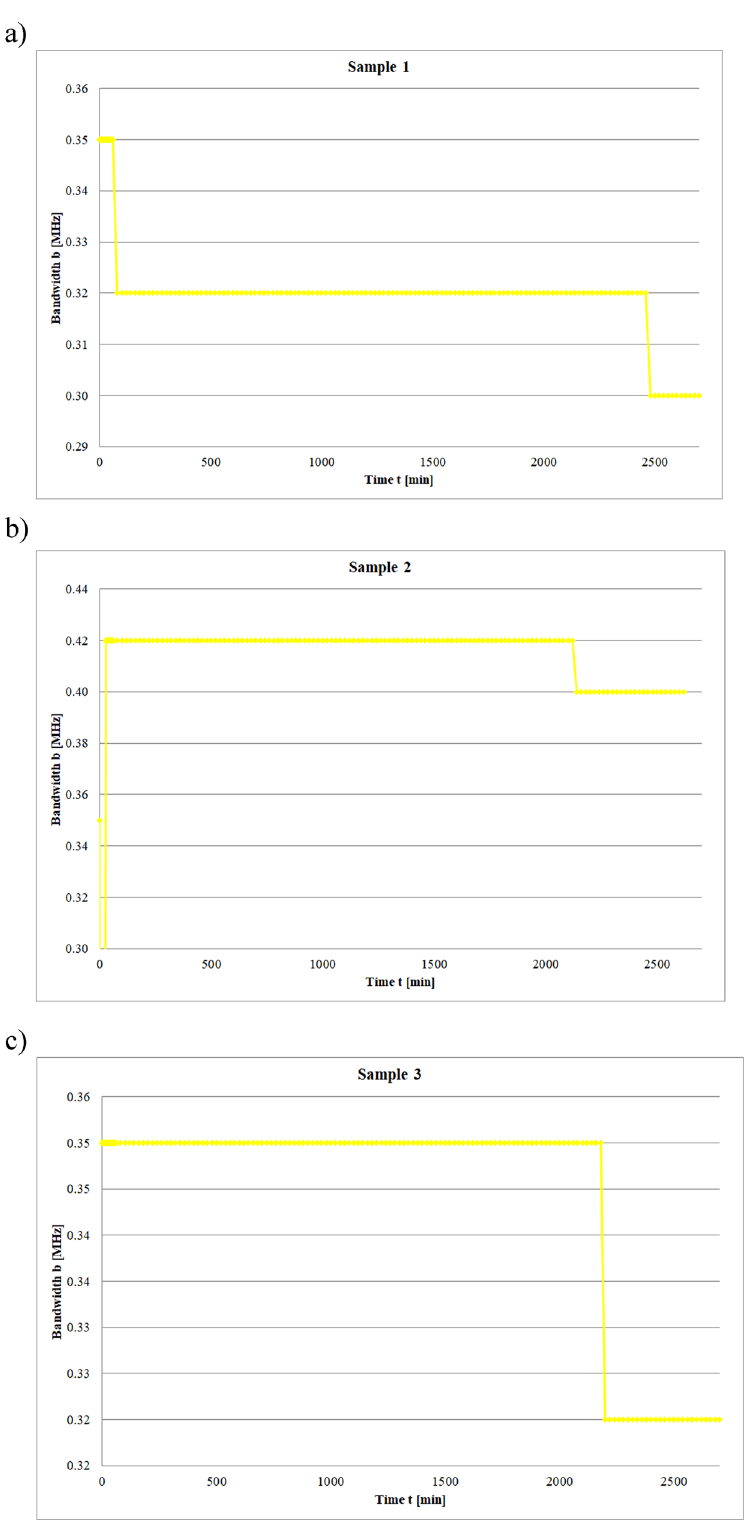
Figure 9: Bandwidth of the ultrasonic wave during the process of constitution and degradation of the coating – substrate joint: ( a ) sample 1, ( b ) sample 2 and ( c ) sample